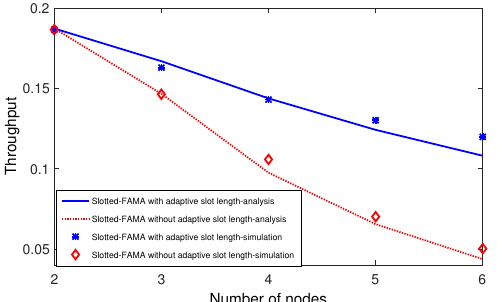
Figure 8. Throughput comparison for Slotted-FAMA with and without adapting the slot length in the network with different